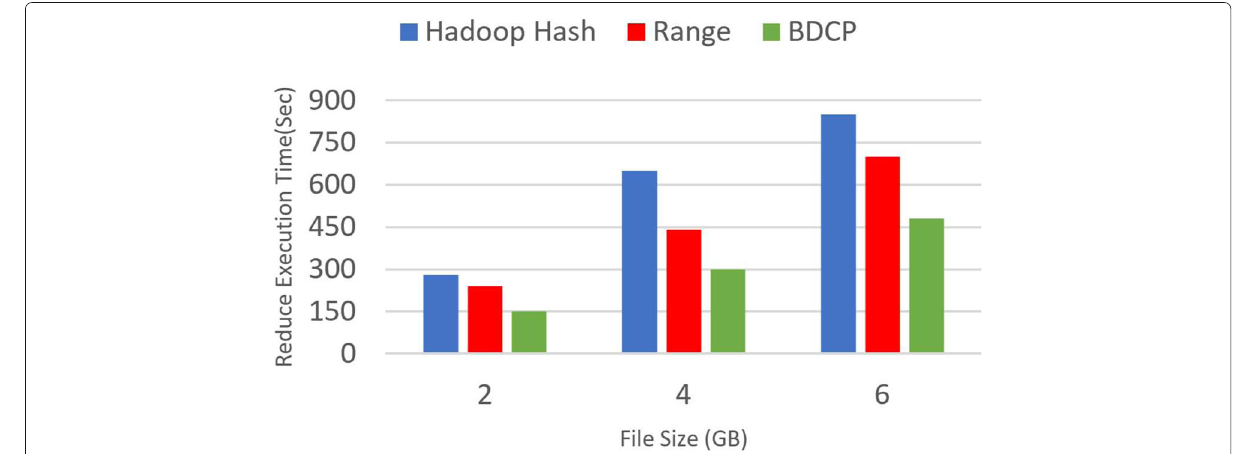
Fig. 15 Word count job on files of sizes, 2, 4, and 6 GB. Skew degree is 1.1